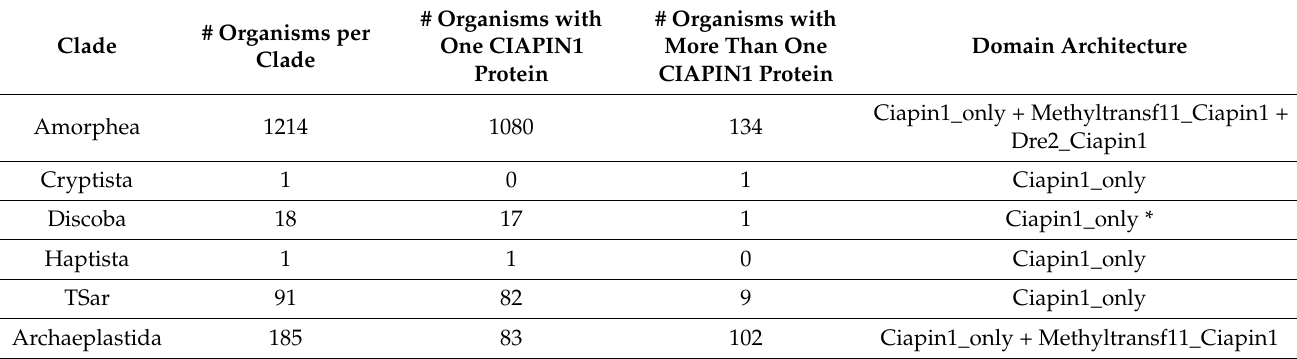
Table 1. Distribution of CIAPIN1 proteins per clade and domain